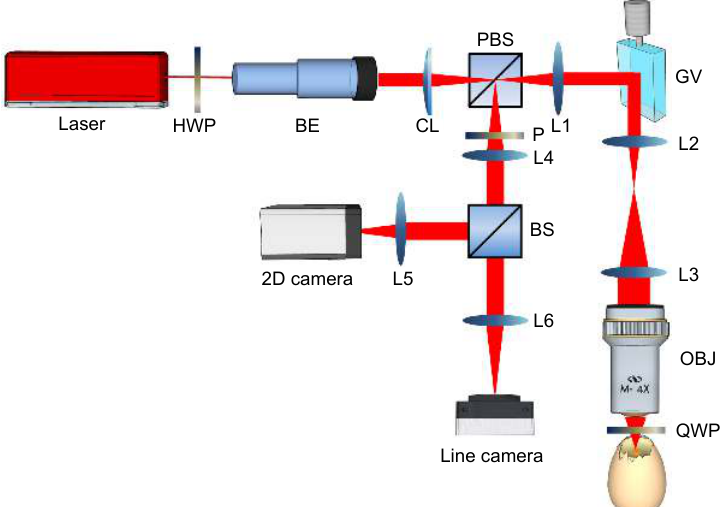
Fig. 1 | Schematic diagram of laser speckle autocorrelation imaging system. HWP, half-wave plate; BE, beam expander (3×); CL, cylindric- al lens; PBS, polarizing beam splitter; GV, 1-D galvo mirror; OBJ, objective lens; QWP, quarter-wave plate; TS, translational stage; P, polarizer. BS, beam splitter (50/50). The focal length of CL is 50 mm. Focal lengths of lenses L1, L2, L3, L4, L5 and L6 are 50, 50, 100, 40, 75 and 100 mm, respectively. The numerical aperture (NA) of the objective lens (4×) is